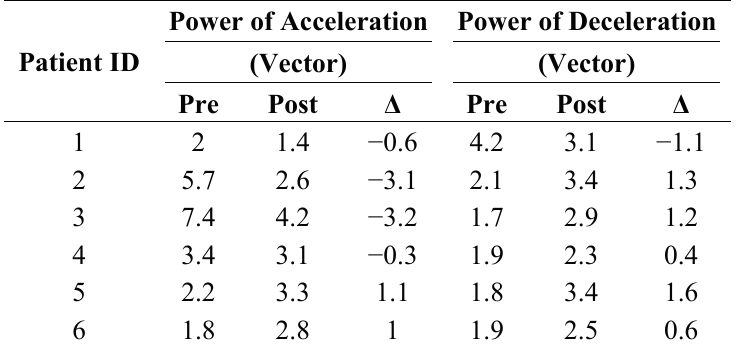
Table 4. Knee velocity parameters during maximum acceleration and abrupt cessation of running before (Pre) and after (Post)